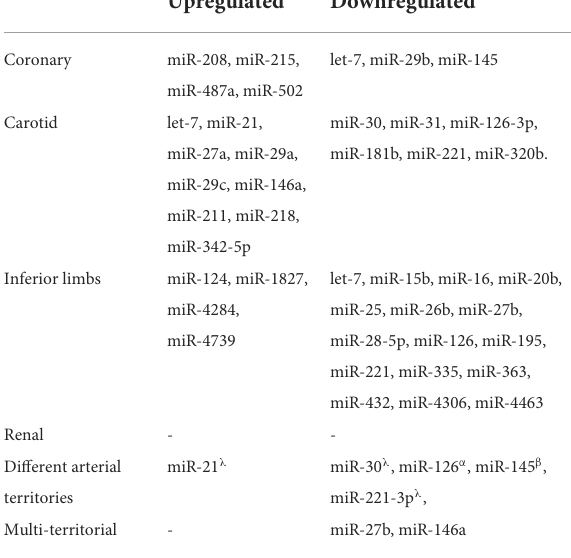
TABLE 1 Most relevant miRNA associated with atherosclerosis of different territories. Upregulated Downregulated